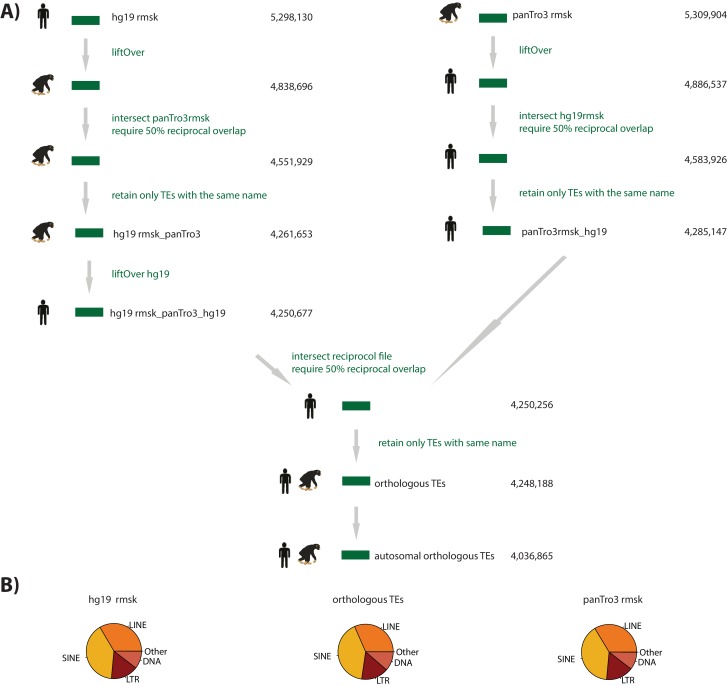
Orthologous TEs reflect the distribution of TE classes in the human and chimpanzee genome.(A) Bioinformatic pipeline to generate orthologous TEs. (B) The proportion of each TE class in the human genome (hg19), chimpanzee genome (panTro3), and our orthologous TE set.